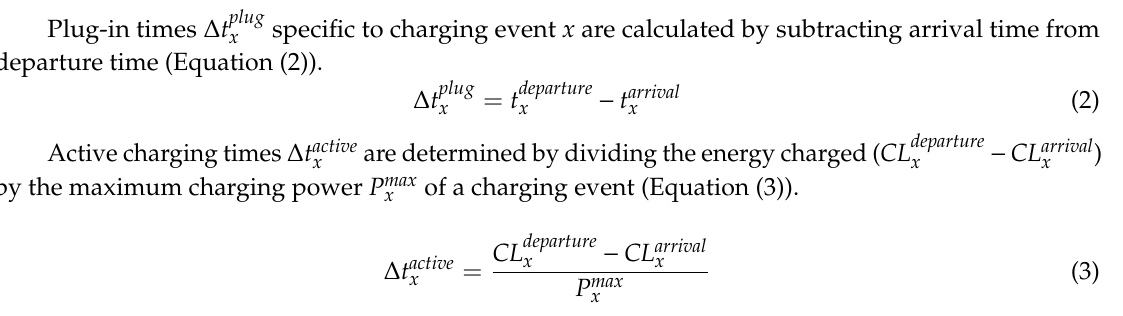
with load-shifting potentials. 𝑥𝑥